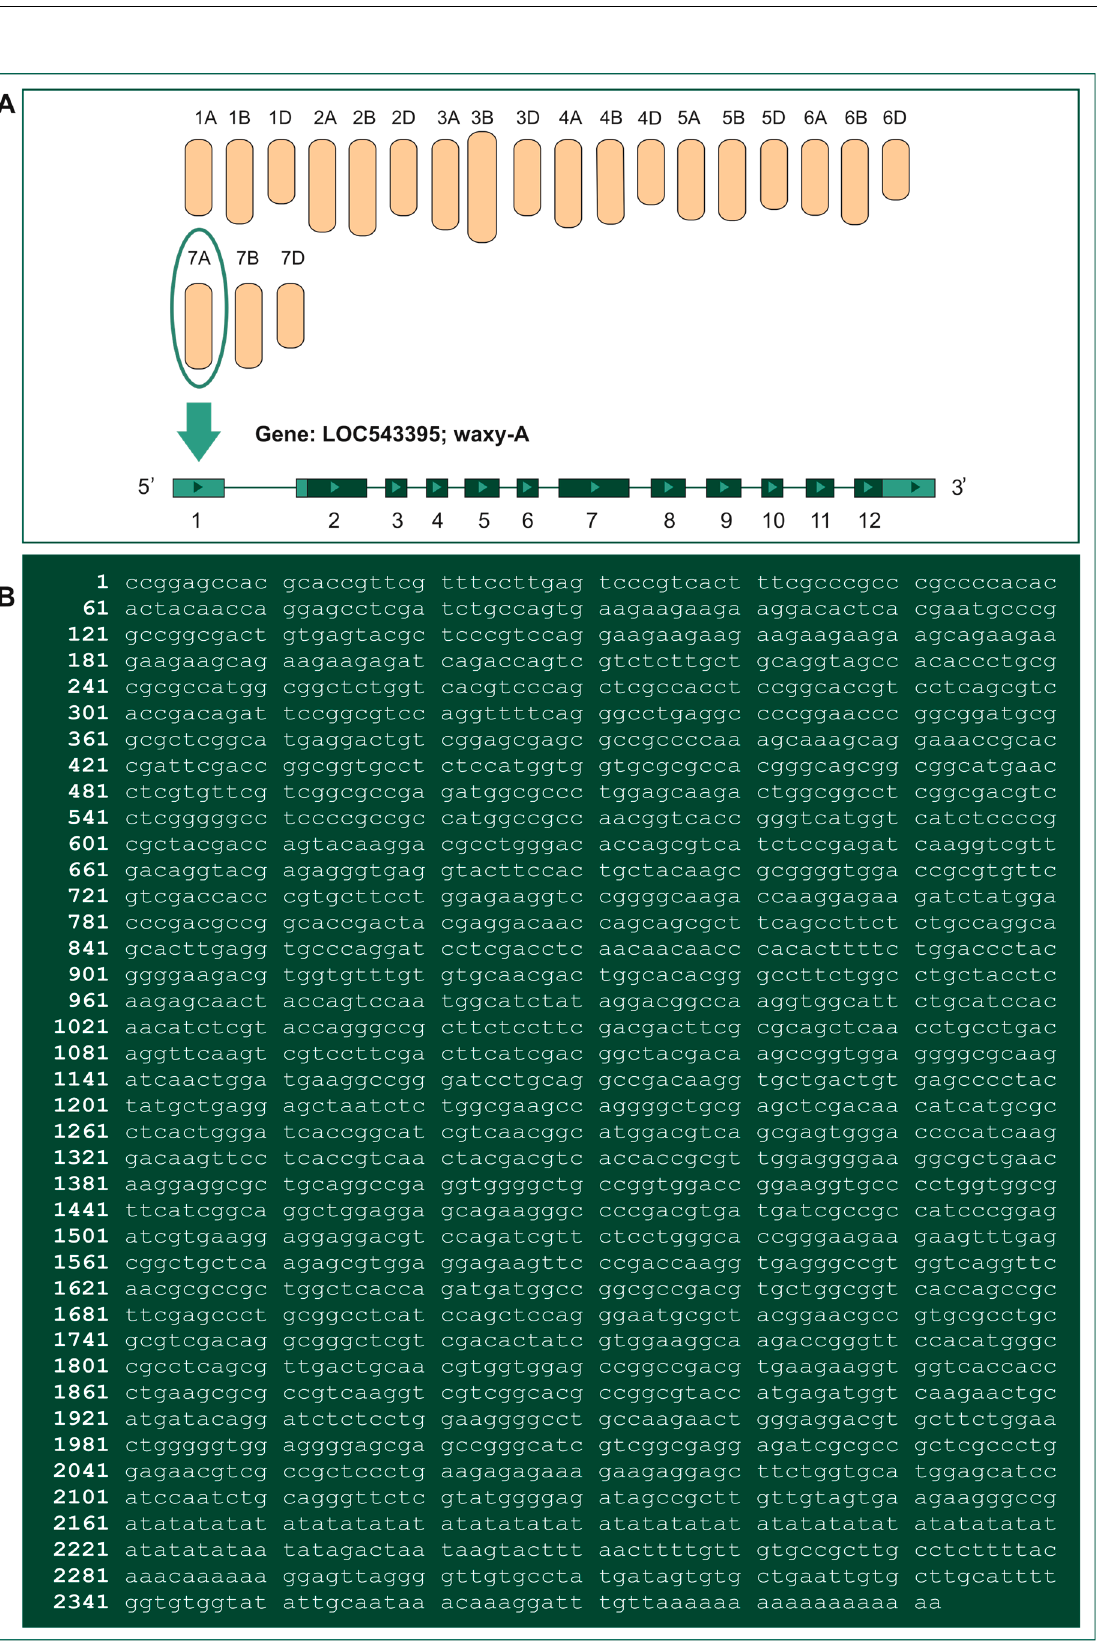
Figure 3. Diagrammatic representation ( A ): of the waxy gene structure, composed of 12 exons and 11 introns Triticum aestivum granule-bound starch synthase 1, ( B ): mRNA; nuclear gene, according to NCBI Reference Sequence: